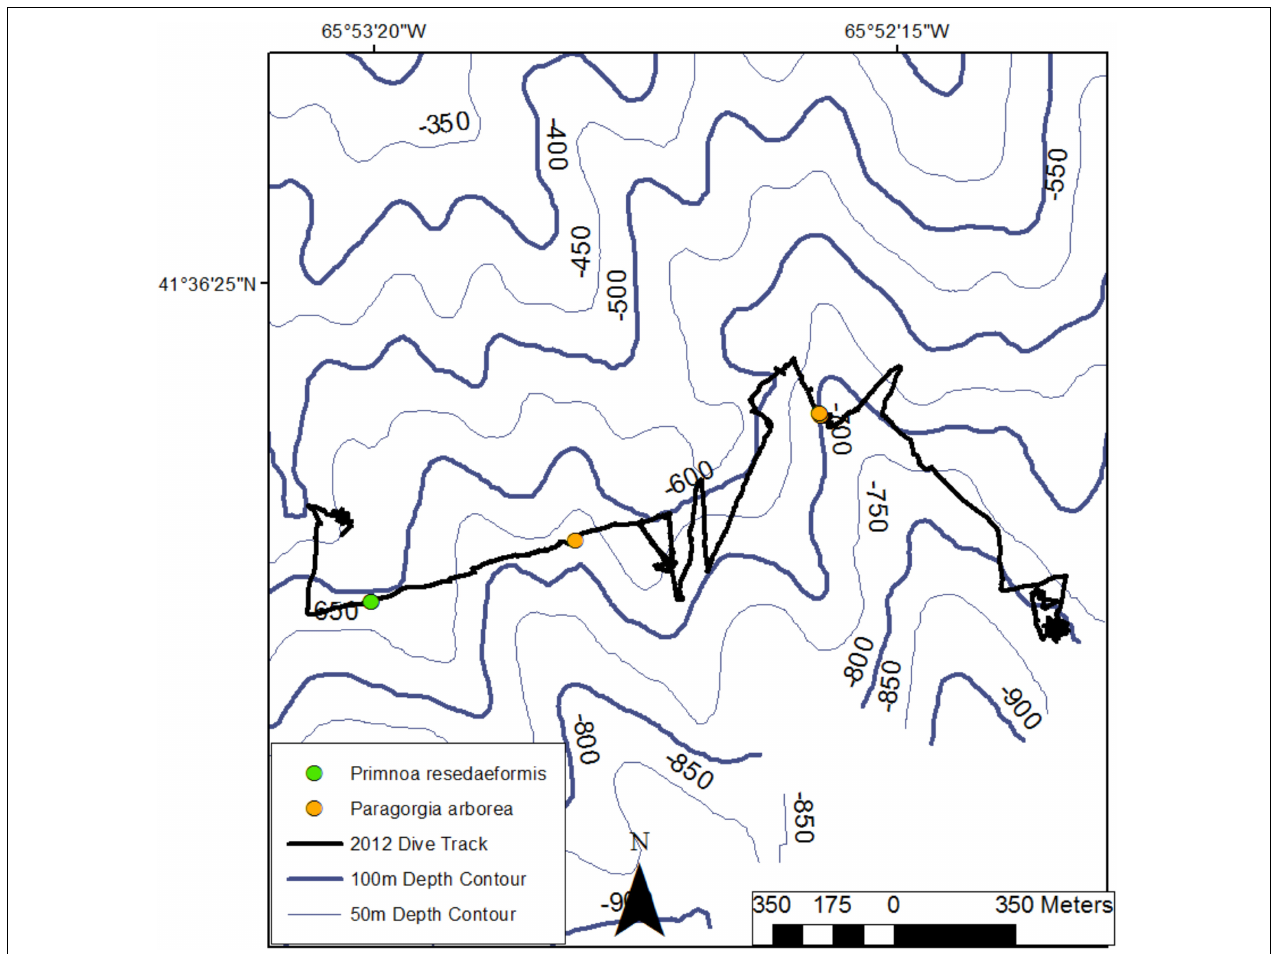
FIGURE 7 | Location of colonies of Paragorgia arborea and Primnoa resedaeformis along the dive track in Fiddlers Cove in 2017 (R2012). NRCan bathymetric data provided by Dr. Brian Kinlan